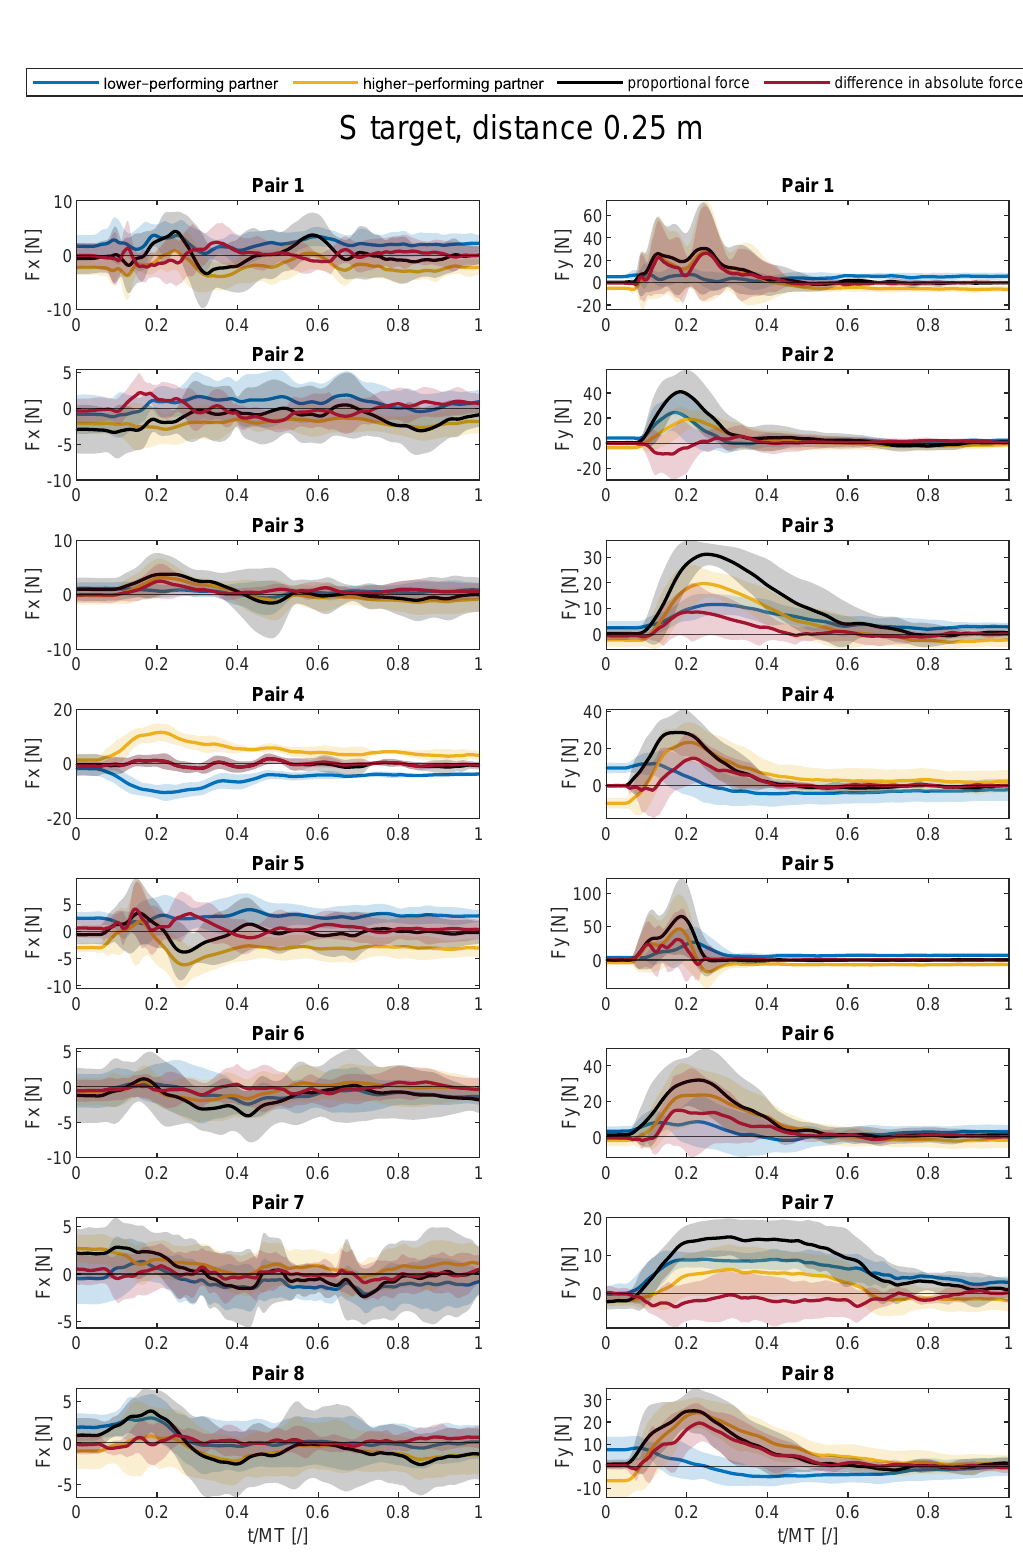
Figure A3. Average force trajectories with standard deviation (shaded area) in x- and y-direction in collaborative task for the small target at the distance of 0.25